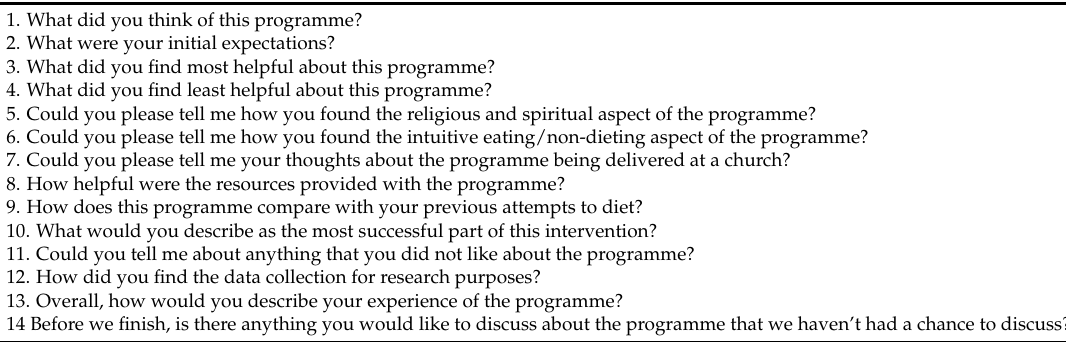
Table 1. Semi-structured interview